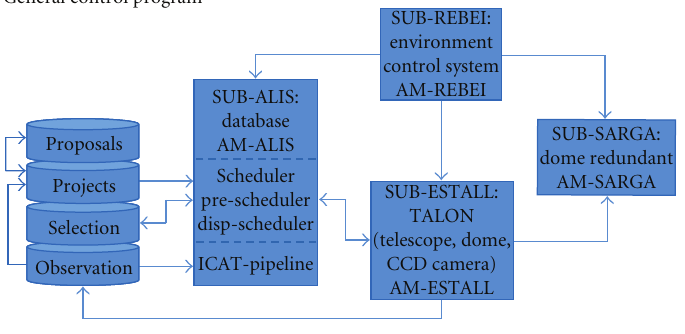
Figure 1: OAdM general control diagram.